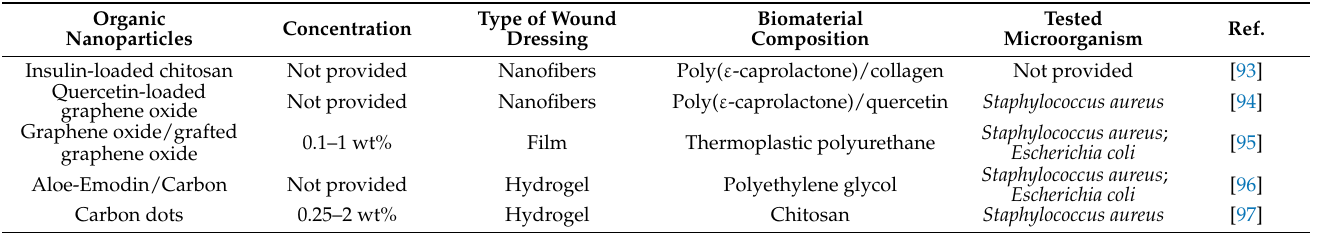
Table 4. Antibacterial non-metallic-nanoparticle-loaded biomaterials for wound healing